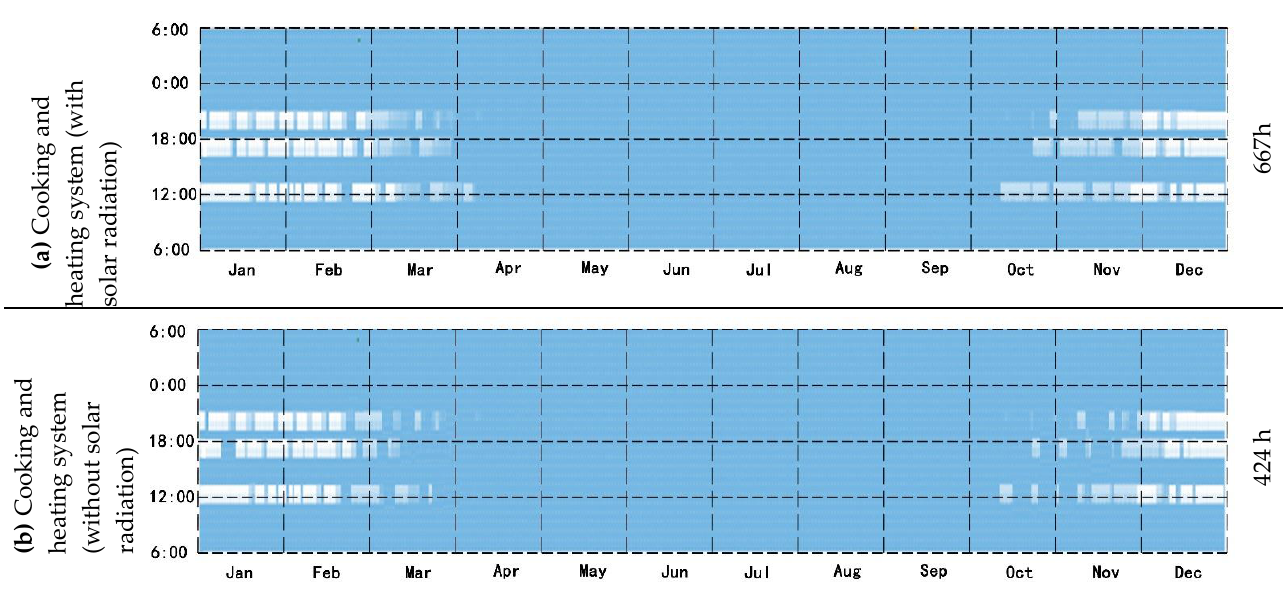
Figure 13. ( a ) Suitable time of the annual average for cooking and heating system with solar radiation; ( b ) Suitable time of the annual average for cooking and heating system without solar radiation.